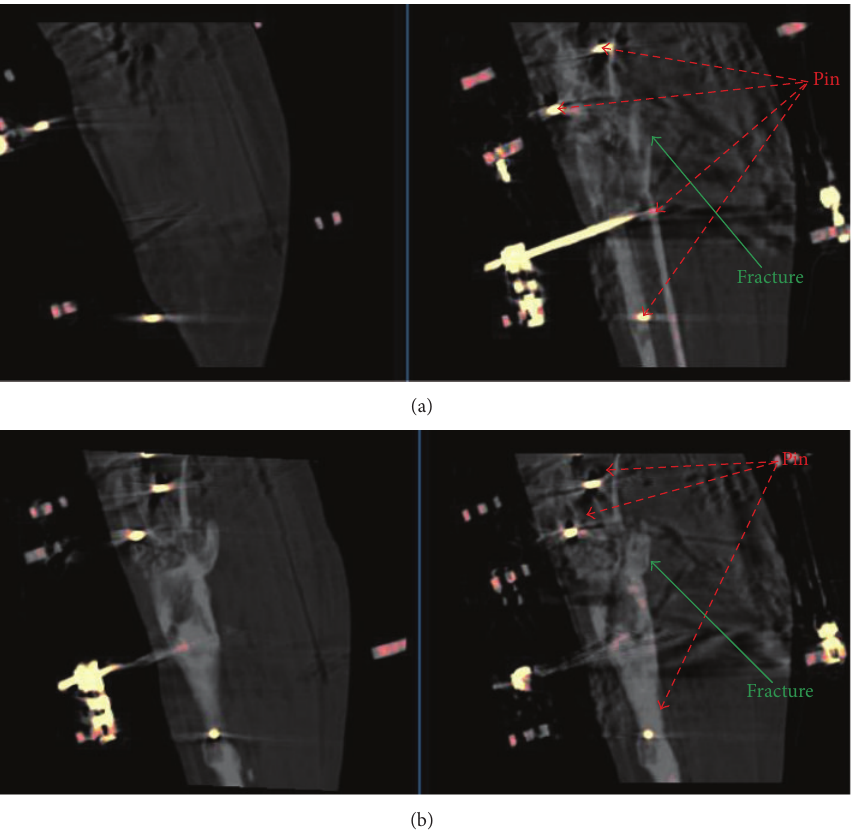
Figure 1: A sagittal CT section for Patient 1 showing the original CT misalignment between the first CT at 40 days (right) and the second CT at 84 days (left) after the operation to attach the TSF (a). A sagittal CT section for Patient 1 showing the final CT transformed alignment between the first CT at 40 days (right) and the second CT at 84 days (left) after the operation to attach the TSF